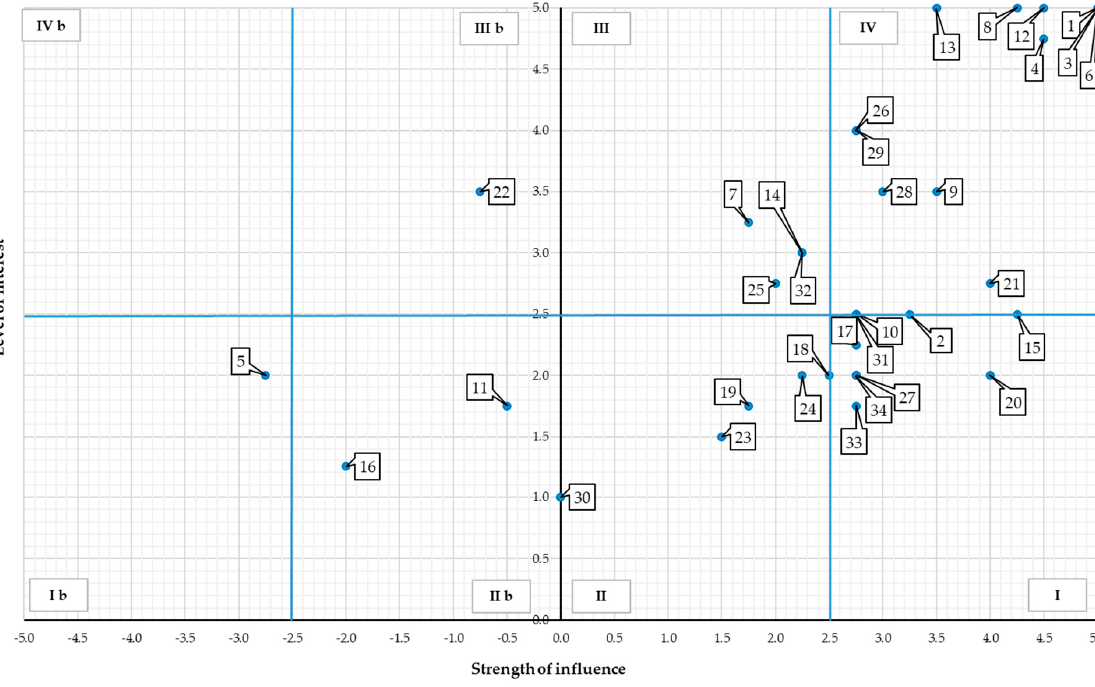
Figure 4. Stakeholder map in business ecosystem: strength of influence—level of interest.